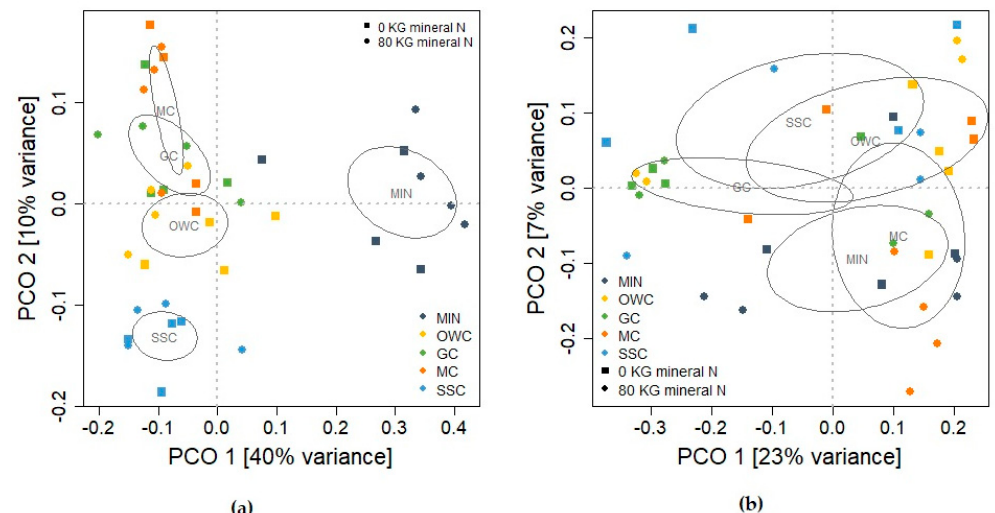
Figure 4. Principal coordinate analysis of ( a ) bacterial/archaeal and ( b ) fungal communities based on 16S and ITS2 genes, respectively. The ordination displays compositional differences between samples based on Jaccard distance. Ellipses indicate the 95% confidence intervals around centroids.